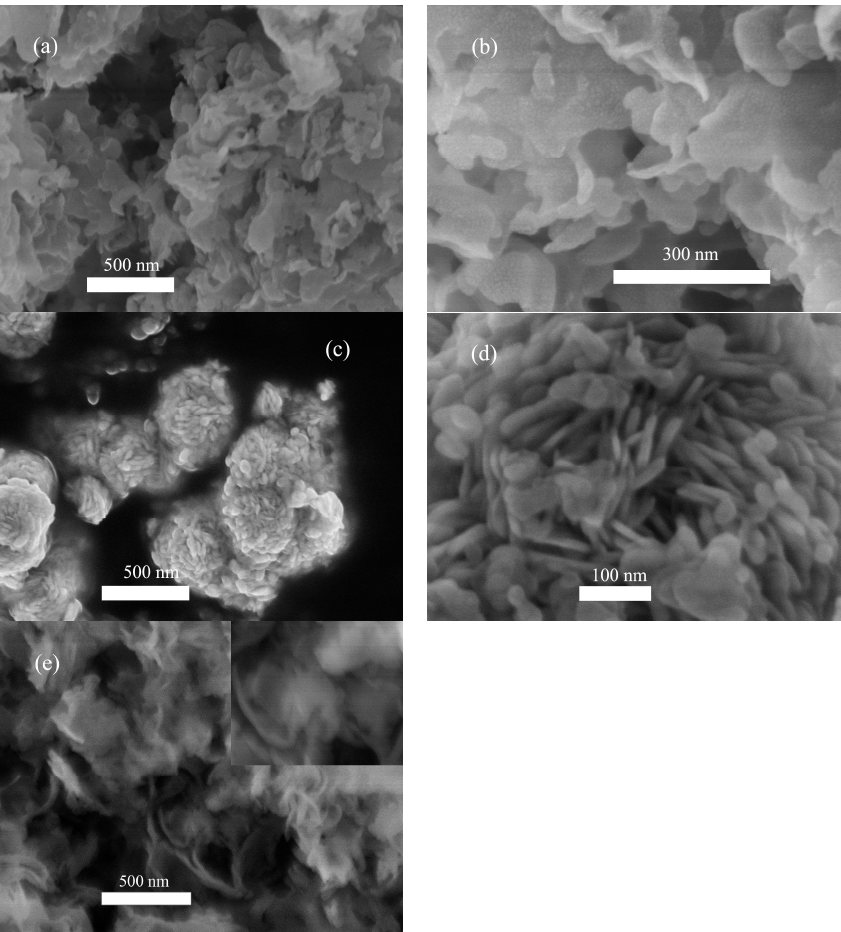
Figure 3. ( a , b ) Low and high magnification FESEM images of the as-obtained g-C 3 N 4 sample; ( c , d ) low and high magnification FESEM images of the as-obtained BiOCl sample; and ( e ) high magnification FESEM image of N 0.45 B 0.55 sample